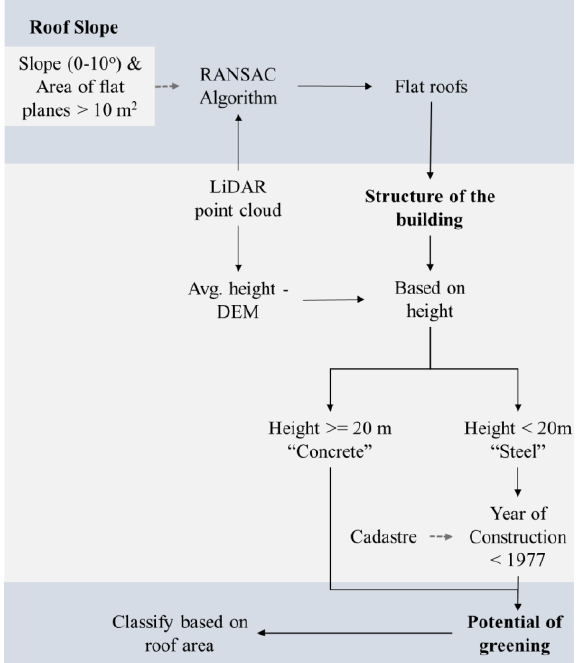
Figure 1. Methodology for identifying the potential of green